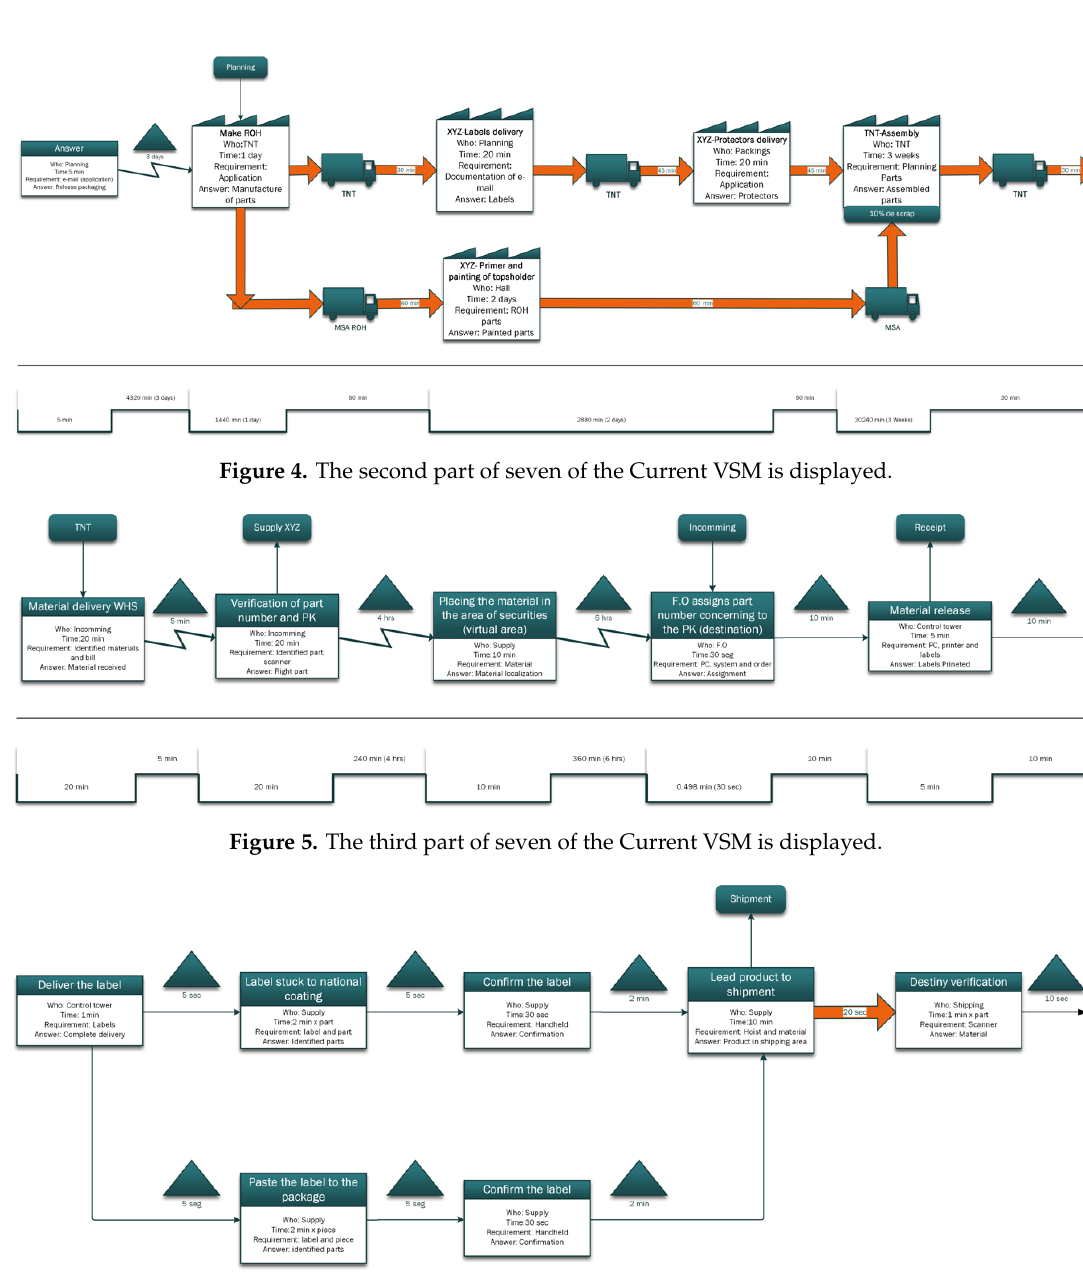
Figure 7. The fifth part of seven of the Current VSM is displayed.